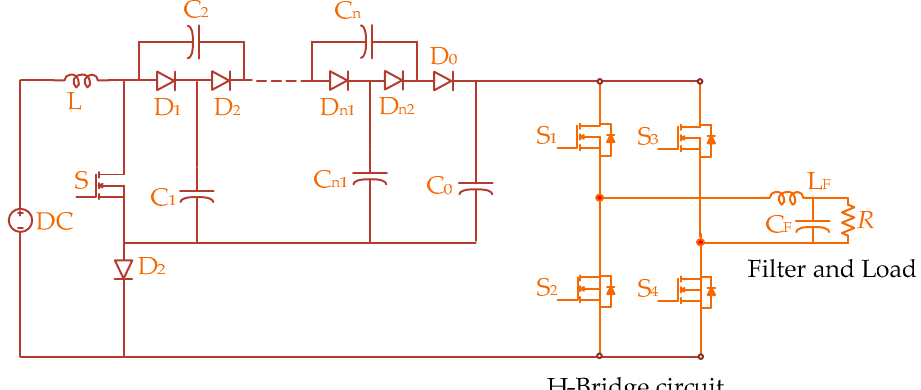
Figure 20. N-cell voltage multiplier cell based quasi-switched boost inverter.